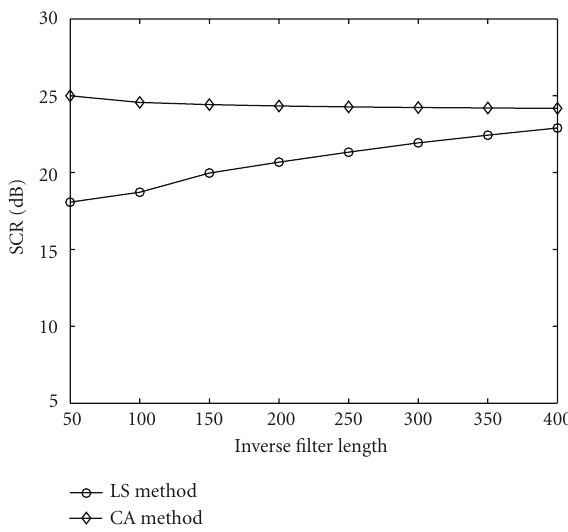
Figure 4: Mean signal-to-crosstalk ratio (SCR) at di ff erent inverse filter lengths for the three methods: the least-squares method (LS), the single-filter structure method (SF), and the CAPZ